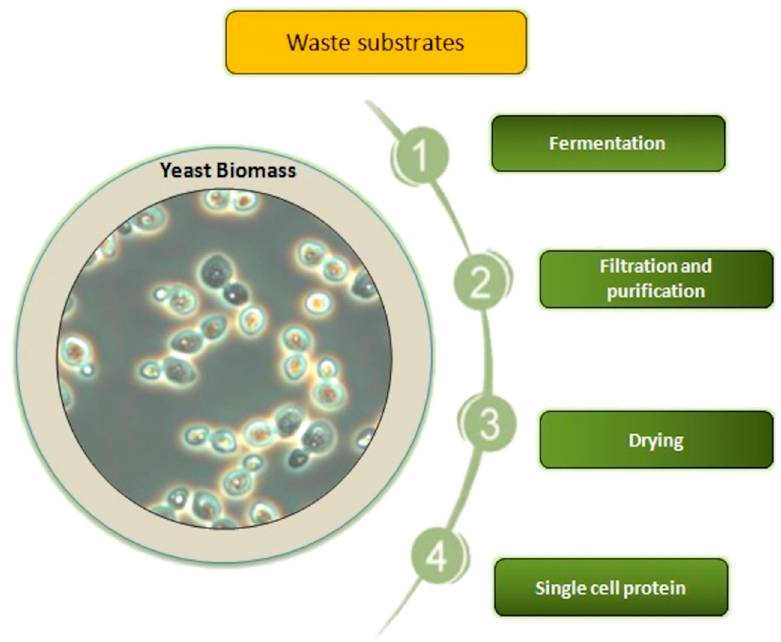
Figure 1. Production of single cell protein by yeast.